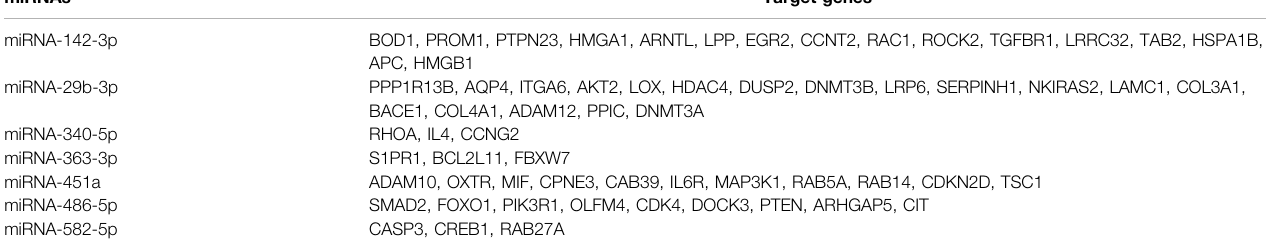
TABLE 5 | Target genes of identi fi ed miRNAs based on TargetScan program and miRTarBase program. miRNAs